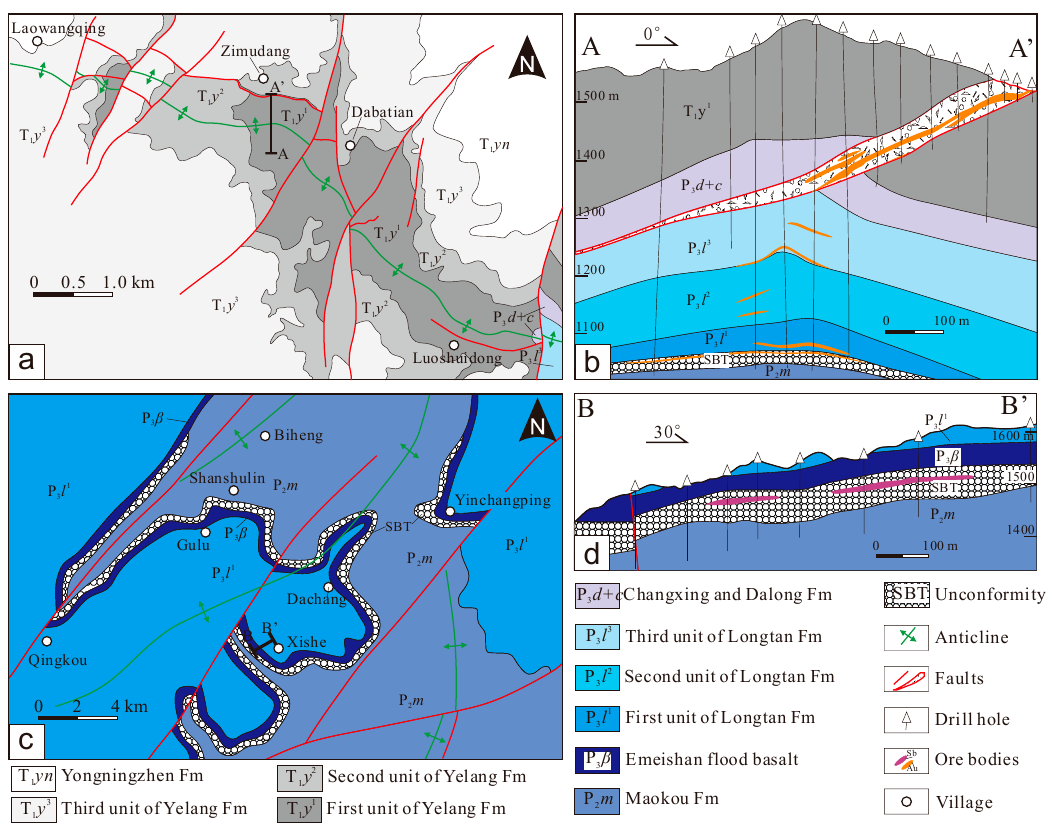
Figure 3. Geologic plan and cross-section of the Zimudang Au deposit ( a , b ) and Dachang Sb deposit ( c , d ). Abbreviations: Fm = Formation.